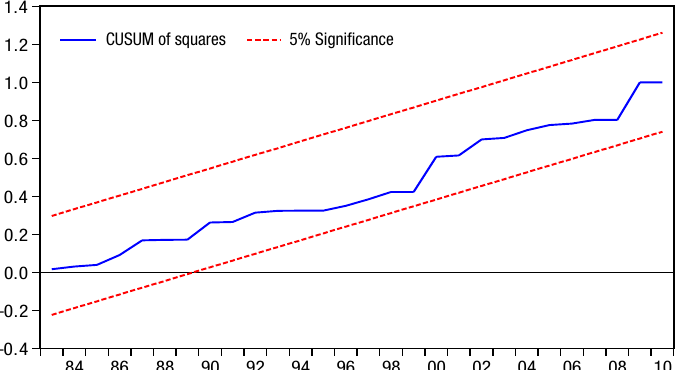
Fig. 6. Plot of cumulative sum of squares of recursive residuals. The straight lines represent critical bounds at 5% significance